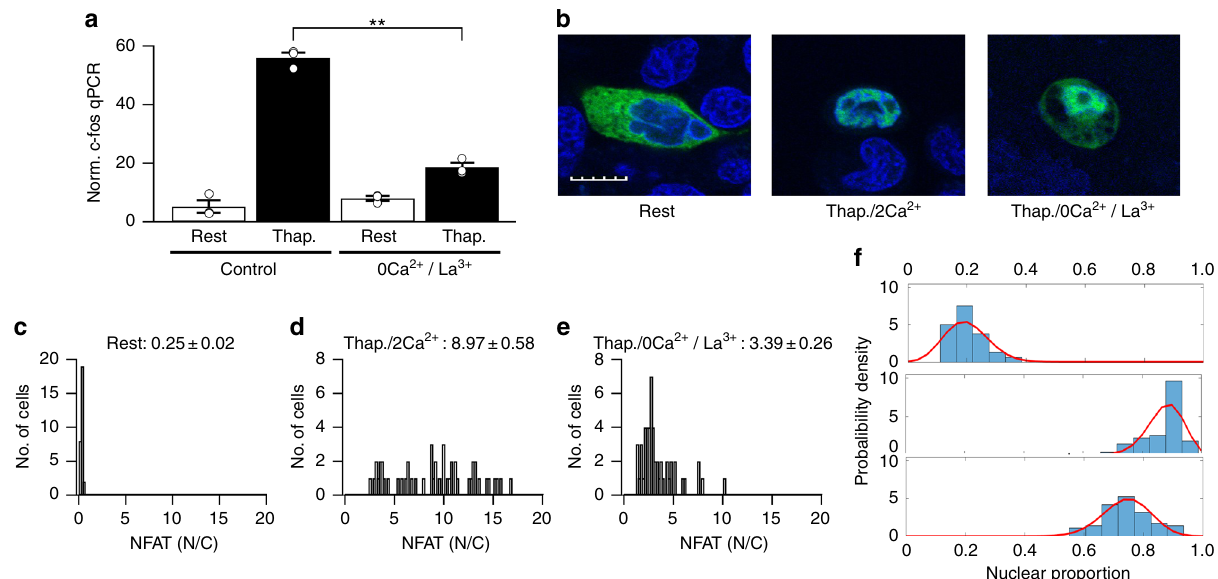
Fig. 7 Effects of a uniform rise in bulk cytosolic Ca 2 + on activation of NFAT and c-fos. a C-Fos transcription, measured with qPCR, is compared for the conditions indicated. Data are mean of three independent experiments. b NFAT1-GFP nuclear migration is compared for the conditions shown. Images were obtained using confocal microscopy. Whole scale bar is 10 μ m. c Histogram plots the NFAT1-GFP nuclear/cytosolic ratio for resting (unstimulated) cells. d As in panel c but cells were stimulated with thapsigargin in 2 mM Ca 2 + . e As in panel c but the stimulus was thapsigargin in Ca 2 + -free solution supplemented with 1 mM La 3 + . The mean nuclear/cytosolic values for all cells in each condition are shown above each histogram. f Binomial distribution fi ts to the data from panels c – e are compared. Thapsigargin was used at 2 μ M in all panels. **denotes p < 0.01, determined using unpaired Student ’ s t -test. Error bars denote